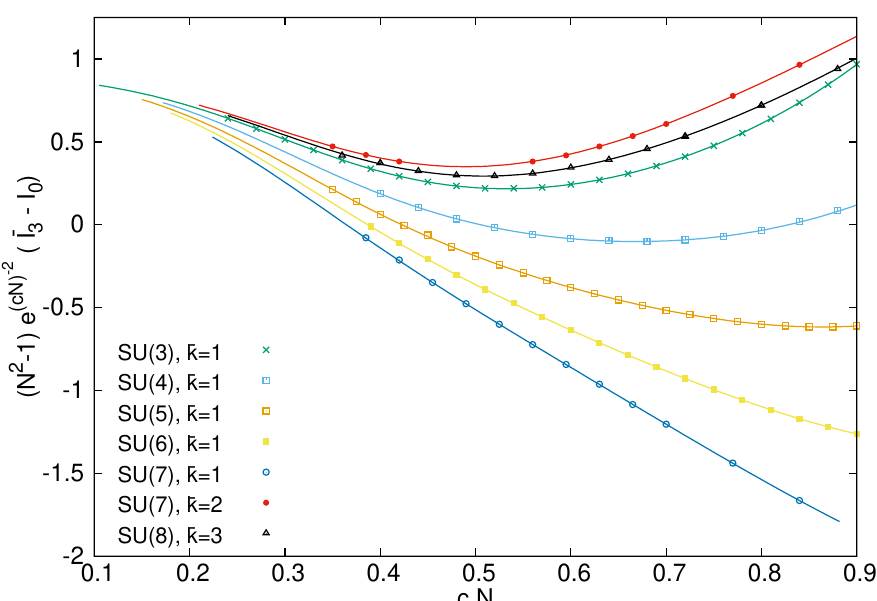
Figure 9. The integral (cid:22) I 3 (cid:0) I 0 multiplied by the factor ( N 2 (cid:0) 1) e ( cN ) (cid:0) 2 , plotted as a function of cN . The continuous line is obtained from the approximate expression given by the sum of eqs. (5.16) and (5.17).